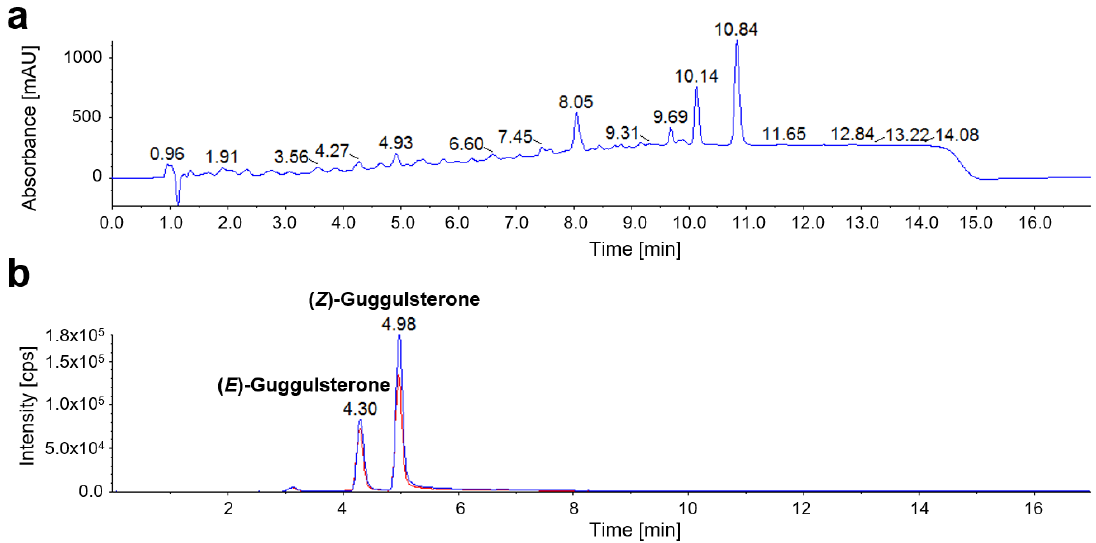
Figure 4. Chromatograms of C. mukul olegum resin. Despite a complex biological matrix, HPLC- MS/MS analysis enabled selective quantification of ( E )-guggulsterone and ( Z )-guggulsterone. Curzerenone, furanoeudsma-1,3-diene, and myrrhone were not detectable in C. mukul . ( a ) Total wavelength chromatogram (TWC) with detection at 210 nm, 254 nm, and 280 nm. ( b ) Multiple reaction monitoring (MRM) chromatogram with m / z 313.3/97.1 as quantifier (blue) and m / z 313.3/109.1 as qualifier (red) for both guggulsterone isomers.